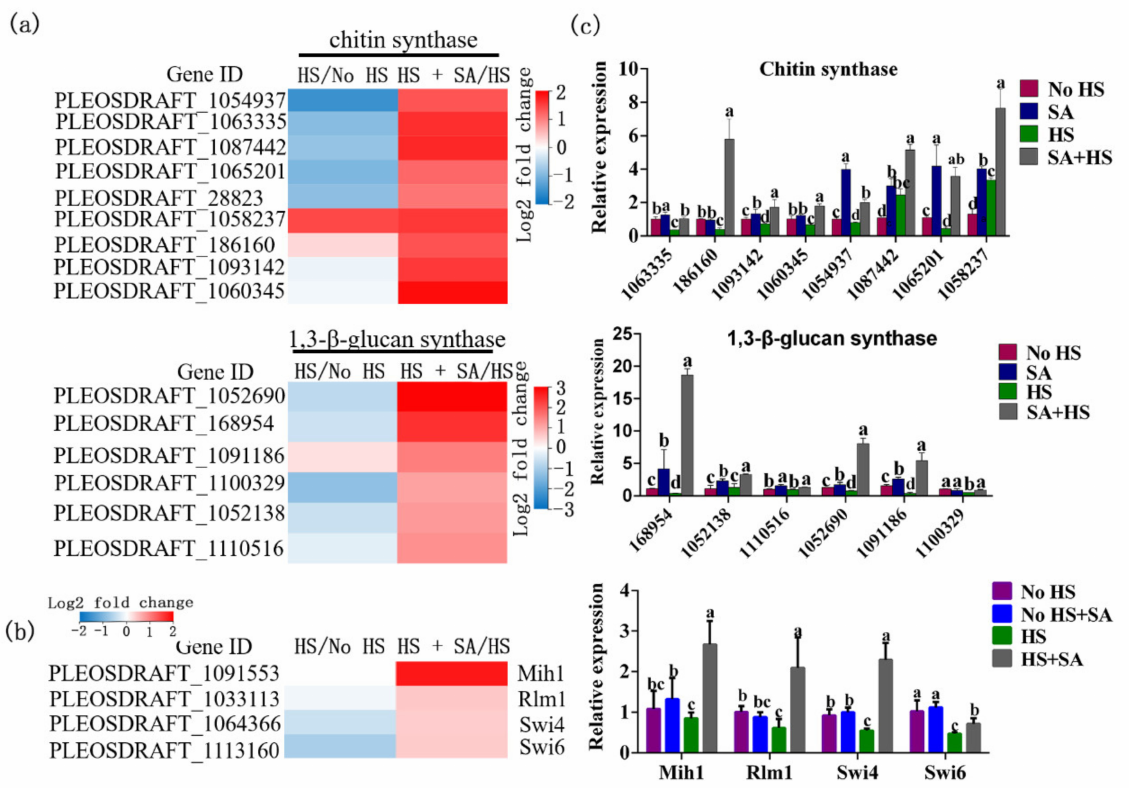
Figure 6. Gene expression analysis of the cell wall integrity pathway. ( a ) Changes in the expression of chitin and 1,3- β -glucan in the HS/No HS and HS + SA/HS groups; ( b ) the expression levels of major factors (Mih1, Rlm1, Swi4, and Swi6) in the “cell wall stress pathway”; ( c ) qRT-PCR results of cell wall integrity pathway genes. Different letters indicate significant differences between strains ( p < 0.05, Tukey’s